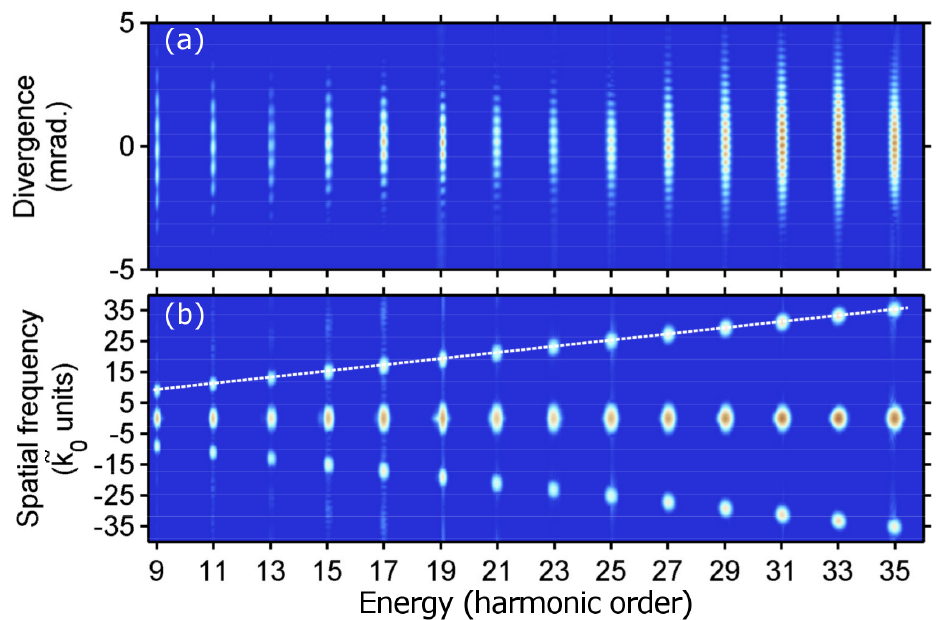
Figure 5. (Color on-line) ( a ) Interference pattern in the SF from the first (H to H ) and second order (H 9 17 ( b ) Fourier transform decomposition in spatial frequencies of the interferogram presented in (a). The dashed line reveals the Young double-slit linear dispersion. Spatial frequencies = 2 π × Γ units (see Equation (1) in the are given in ˜ k 0 λ 0